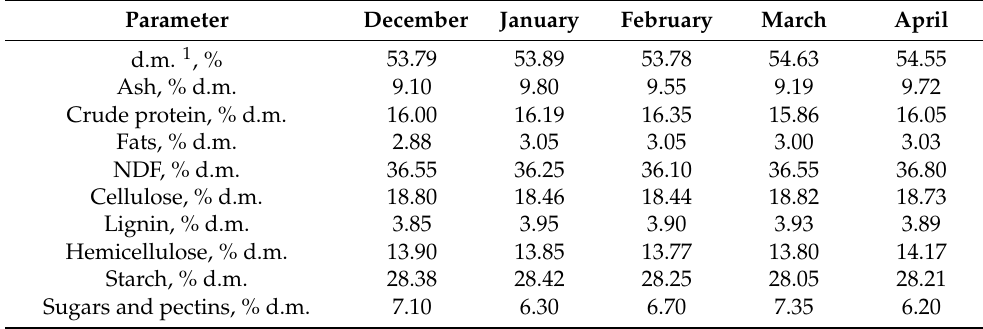
Starch, % d.m. Sugars and pectins, % d.m.